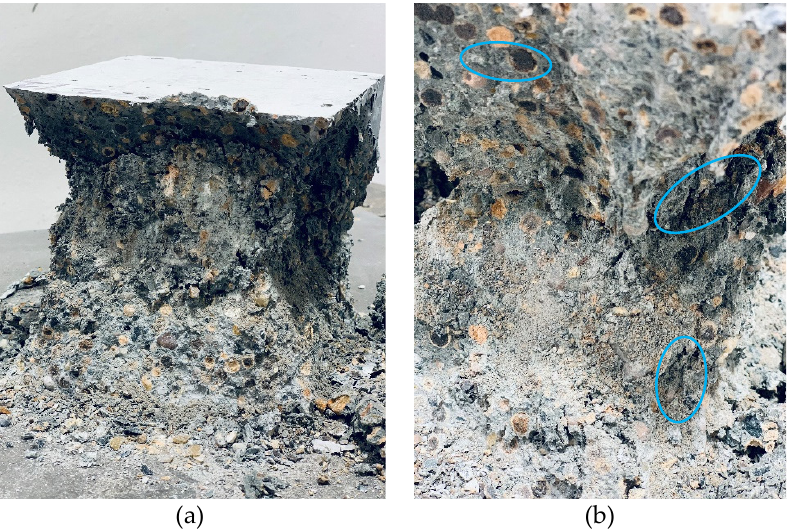
Figure 5. Mechanical properties of concretes.